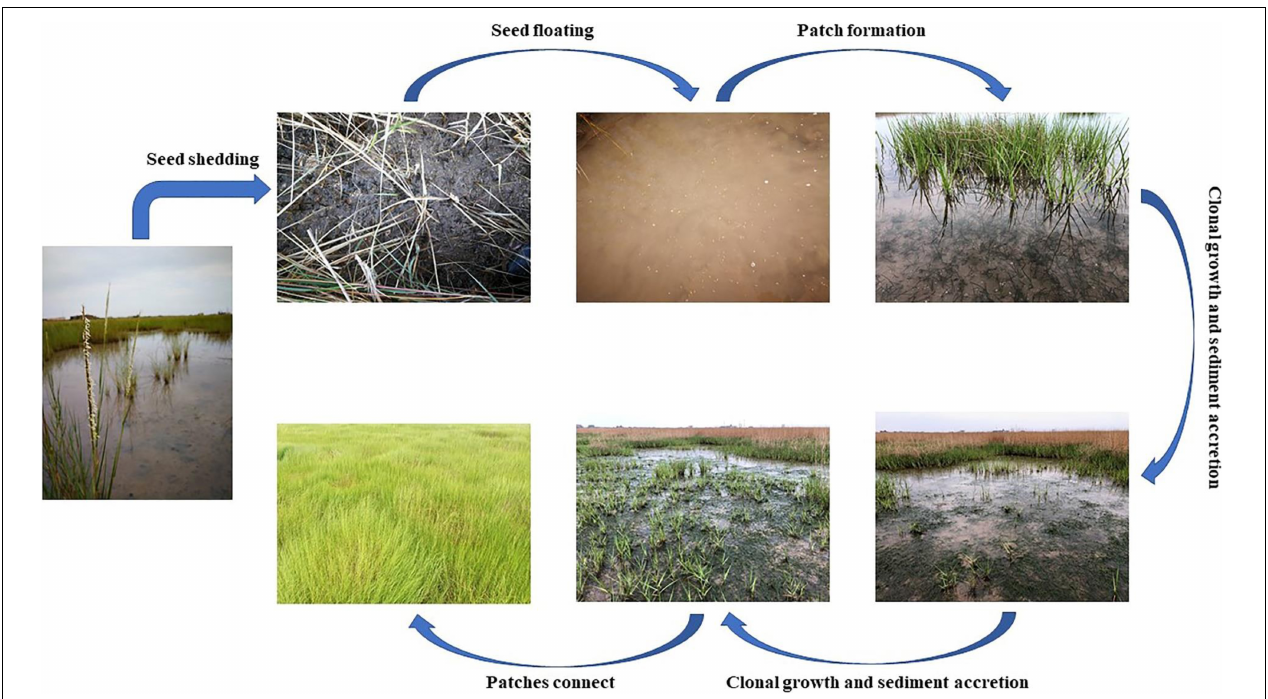
FIGURE 11 | The invasion pattern of Spartina alterniflora in Zostera japonica